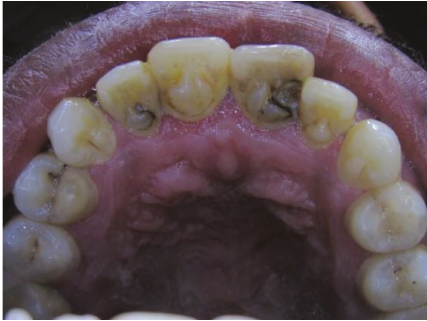
Figure 7: Case 2: talon cusps in all upper anterior